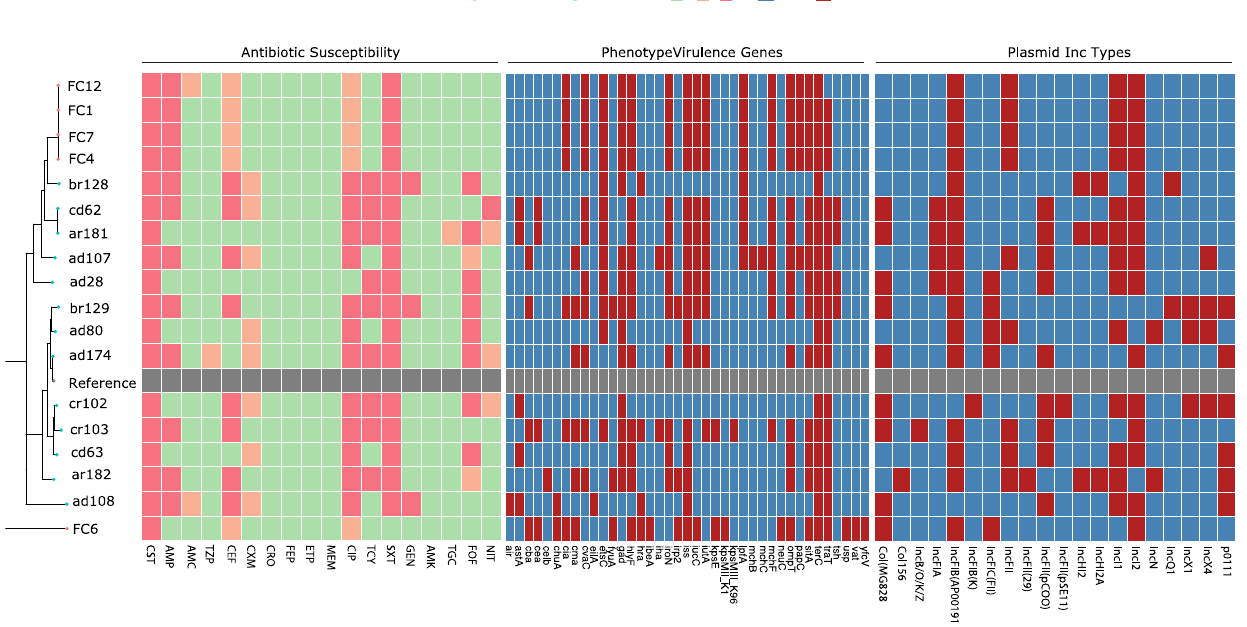
Figure 1. Phylogenetic tree, antimicrobial susceptibility profiles, virulence factors, and plasmid incompatibility (Inc) types of the 18 mcr-1 -carrying Escherichia coli isolated from retail chicken carcasses and broiler chicken fecal samples. E. coli K-12 MG1655 (GenBank: CP014225.1) was used as a reference strain for the phylogeny and indicated in grey. The antibiotics tested were ampicillin (AMP), amoxicillin-clavulanic acid (AMC), piperacillin-tazobactam (TZP), cephalothin (CEF), cefuroxime (CXM), ceftriaxone (CRO), cefepime (FEP), ertapenem (ETP), meropenem (MEM), ciprofloxacin (CIP), tetracycline (TCY), sulfamethoxazole-trimethoprim (SXT), gentamicin (GEN), amikacin (AMK), fosfomycin (FOF), nitrofurantoin (NIT), and colistin (CST). S, I, and R correspond to susceptible, intermediate, and resistant in the antibiotic susceptibility profiles, respectively. For the virulence factors and plasmid Inc types, red indicates presence, and blue indicates the absence from the genome assembly.